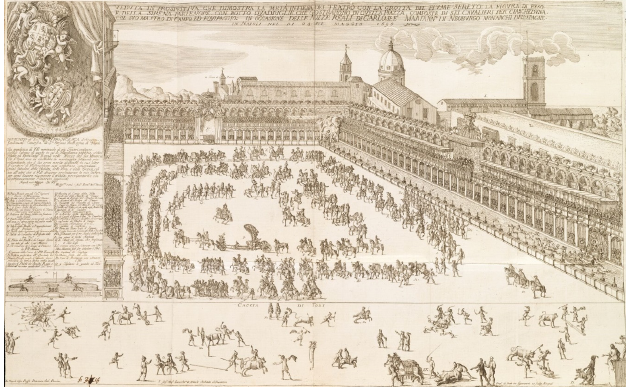
Figure 15. Festival Representation for tournaments in the Plaza del Royal Palace, 1690 of F. De Grado in Parrino D.A. (ed.), L’ossequio tributario della fedelissima città di Napoli per le dimostranze giulive nei regii sponsali del cattolico, ed invittissimo monarca Carlo secondo colla serenissima principessa di Neoburgo palatina del Reno..., Napoli, Italia 1690 [22].